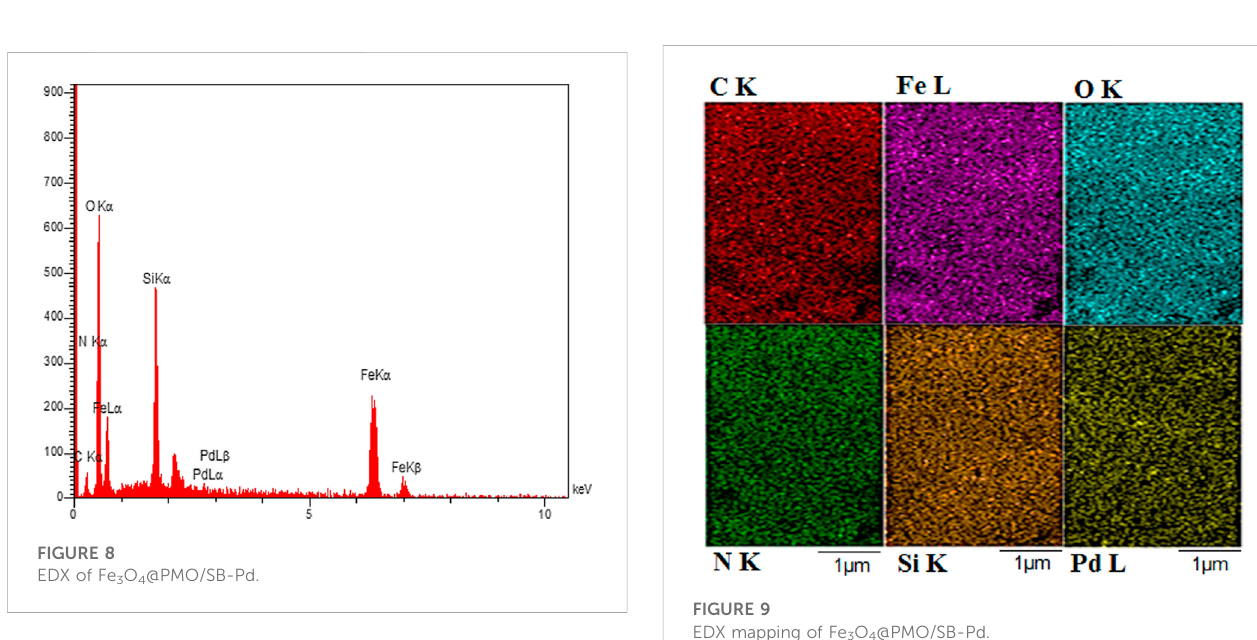
FIGURE 9 EDX mapping of Fe 3 O 4